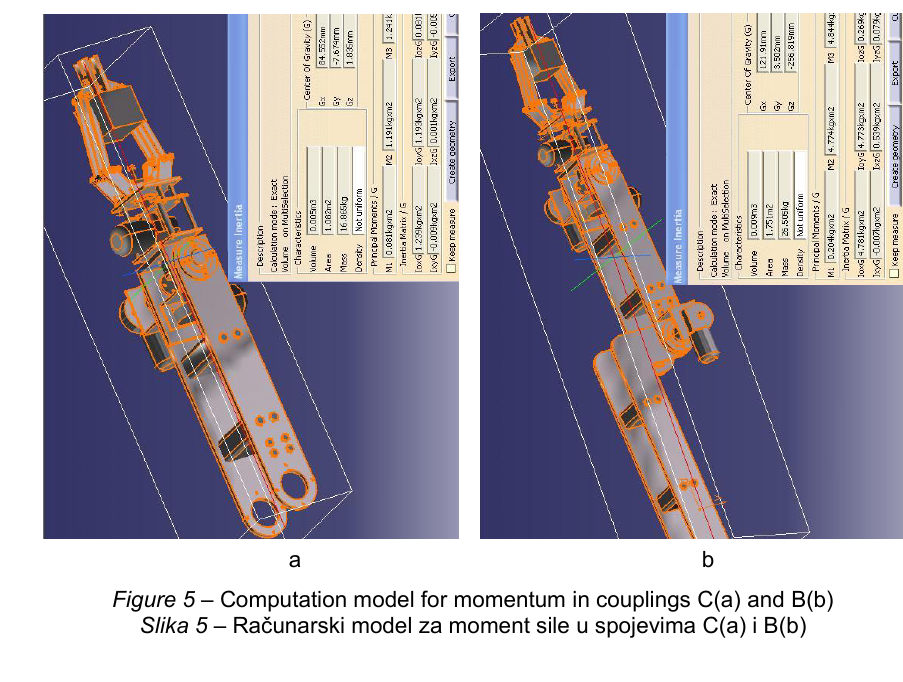
Figure 5 – Computation model for momentum in couplings C(a) and B(b) Slika 5 – Ra č unarski model za moment sile u spojevima C(a) i